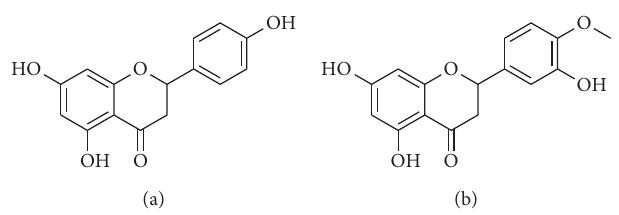
Figure 1: Chemical structure: (a) naringenin and (b)